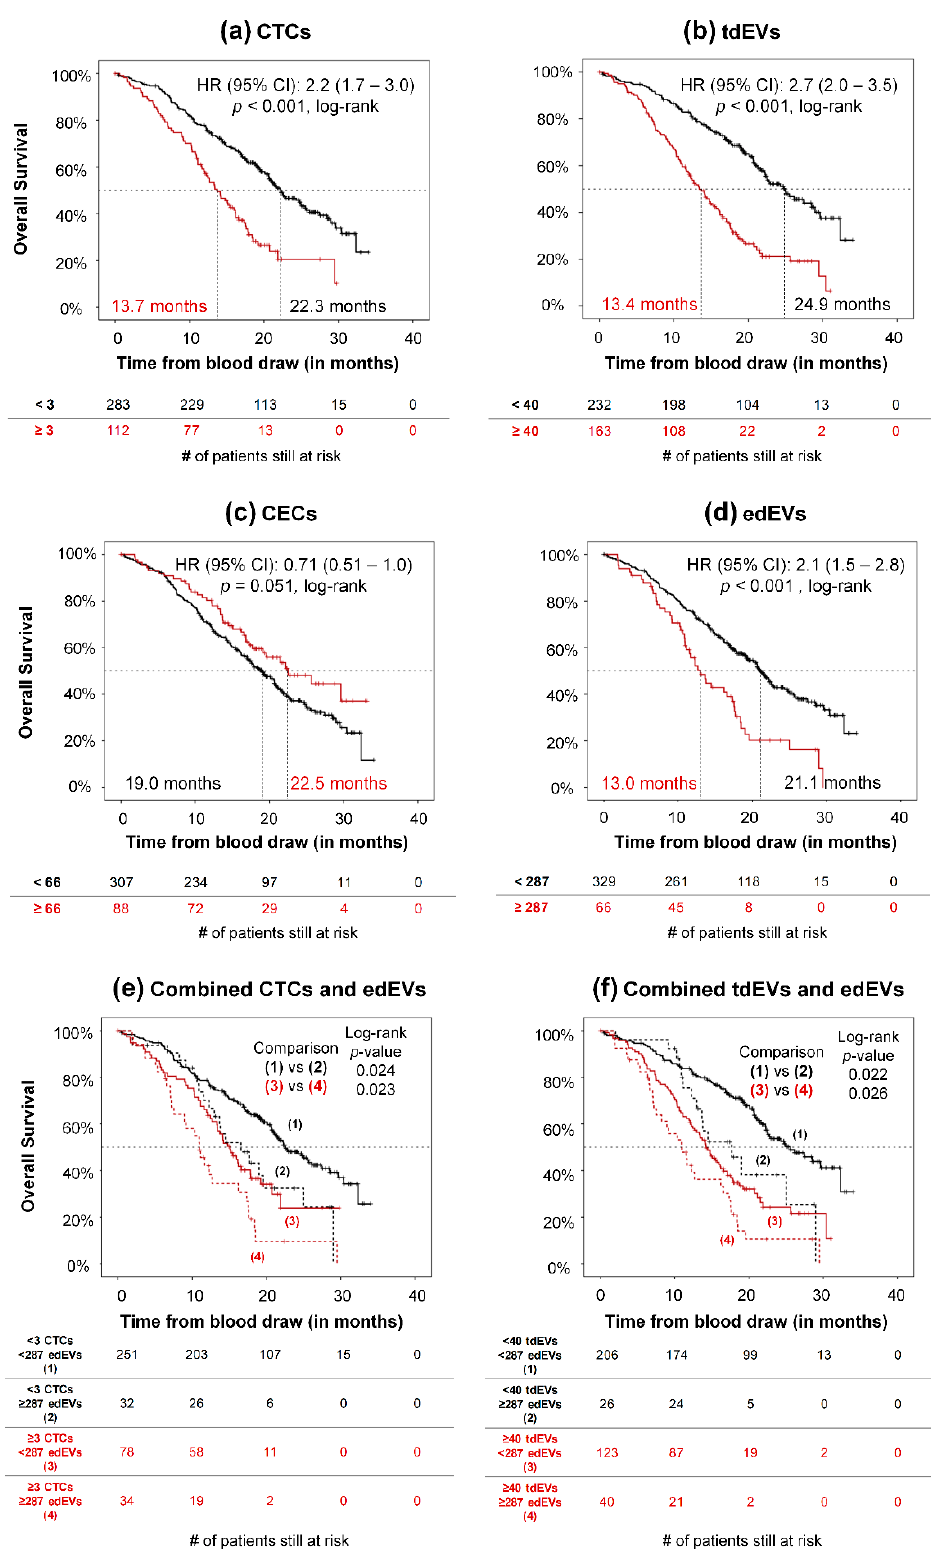
Figure 5. Association of CTCs ( a ), tdEVs ( b ), CECs ( c ), edEVs ( d ), combined CTCs and edEVs ( e ), and combined tdEVs and edEVs ( f ) with overall survival of 395 mCRC patients before the initiation of a new therapy.